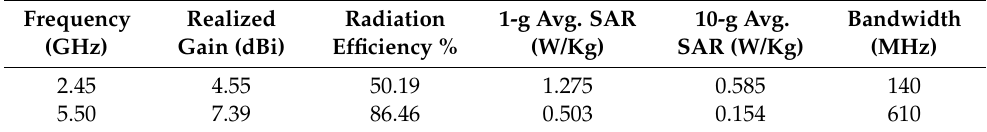
Table 2. SAR and antenna gain and bandwidth summary for h = 6 mm and air − gap = 2 mm.